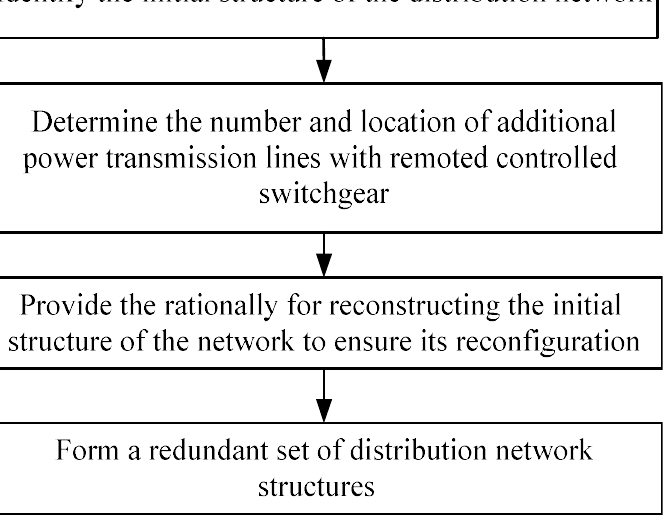
Figure 1. Flowchart of the method for selecting the structure of a flexible distribution network.